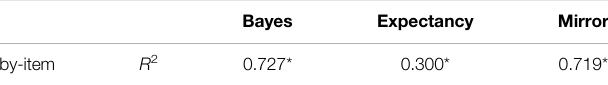
TABLE 8 | Correlations between observed data and model predictions in Experiment 2, by items. * indicates signi fi cance at or below 0.001. Bayes Mirror